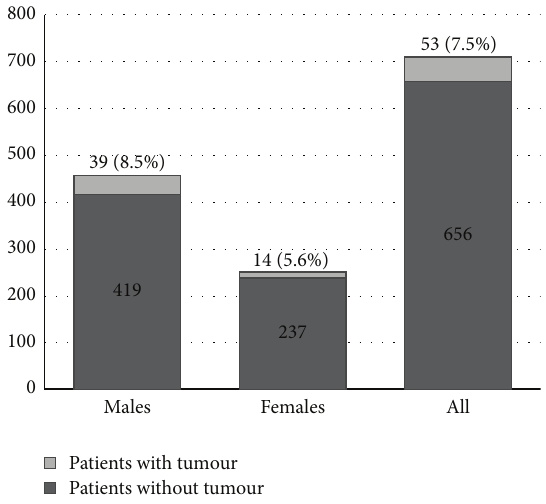
Figure 1: The absolute numbers and percentages of male and female kidney transplant recipients in our study population who received a renal transplant between 1995 and 2008 and had developed a malignant skin tumour at the time of data collection.